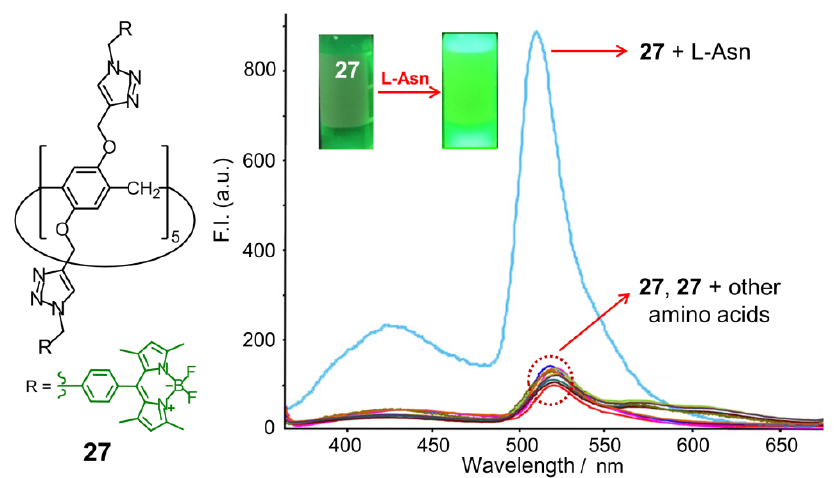
Figure 18. BODIPY-functionalized pillar[5]arene 27 for selective turn-on fluorescence recognition of L-Asn in DMF–H 2 O (1:1, v / v ) media. Reproduced with permission from Reference [100]. Copyright 2020